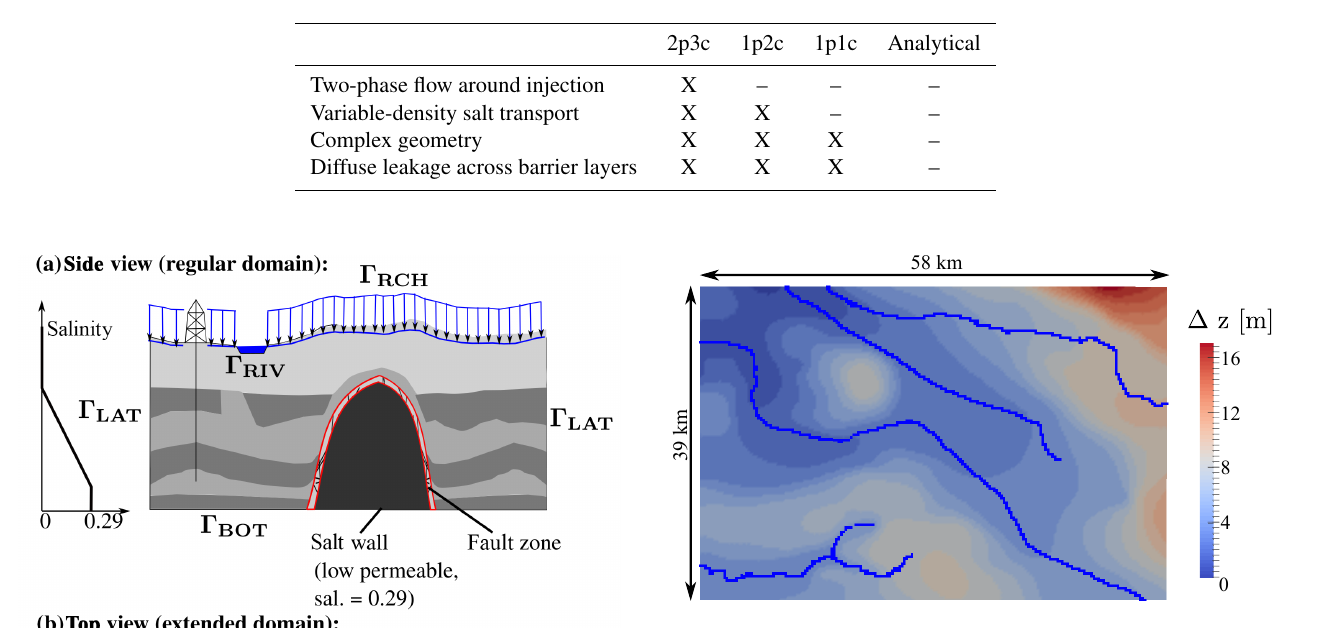
Table 2. Overview of the different models and the processes which are neglected.